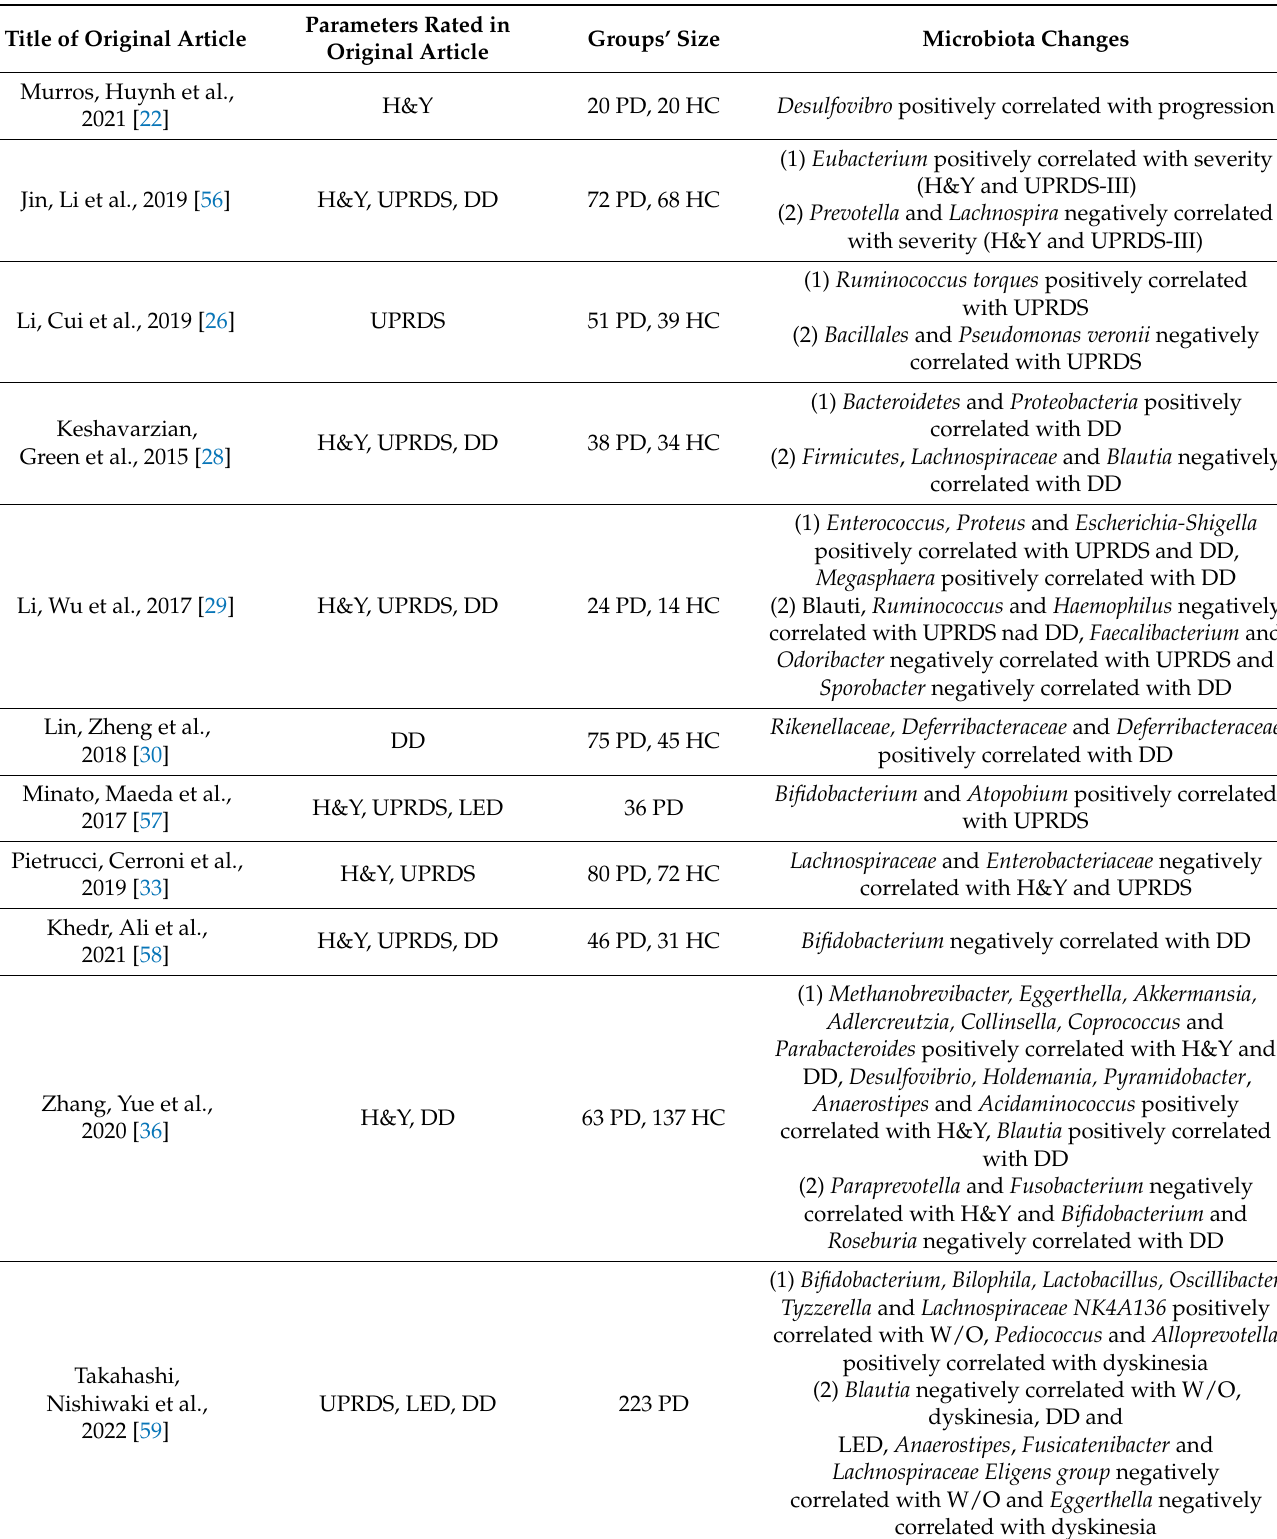
Table 2. Parkinson disease severity: research papers and their conclusions (H&Y—Hoehn and Yahr Scale, UPRDS—Unified Parkinson’s Disease Rating Scale, LED—Levodopa Equivalent Dose, UPRDS- III—Unified Parkinson’s Disease Rating Scale 3rd part, DD— disease duration, PD—patient with Parkinson’s disease, HC—healthy control, DC—diseased